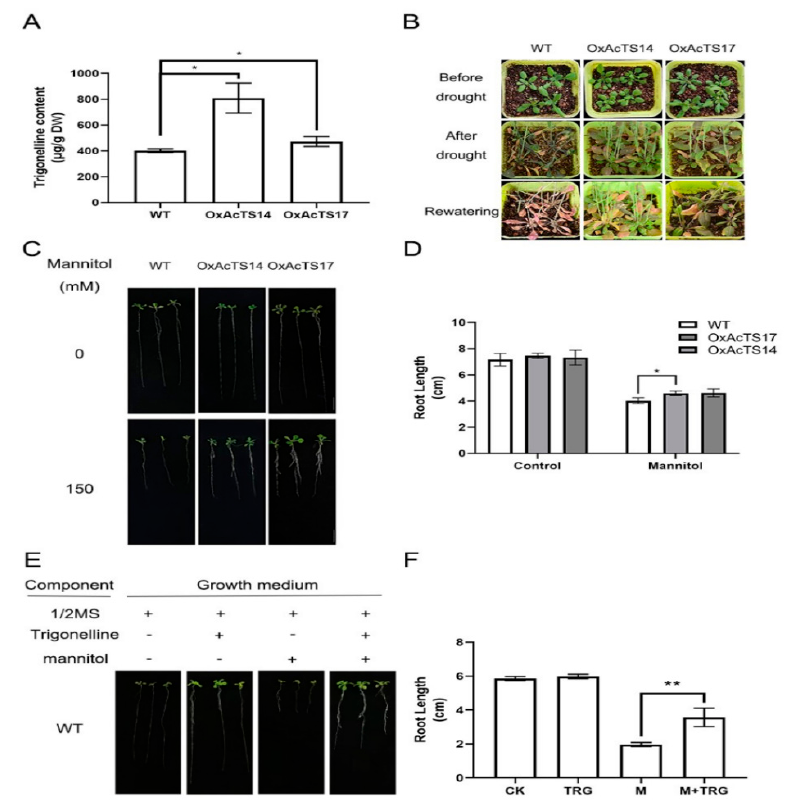
Figure 5. The potential role of AcTS in response to drought. ( A ) The content of trigonelline in Col-0 and transgenic Arabidopsis overexpressing AcTS (OxAcTS14 and OxAcTS14). ( B ) The phenotype of Col-0 and OxAcTS under drought and rehydration treatments. ( C ) The phenotype of Col-0 and OxAcTS on half-strength MS medium and half-strength MS medium supplemented with mannitol. ( D ) The root length of Col-0 and OxAcTS on half-strength MS medium and half-strength MS medium supplemented with mannitol. ( E ) The phenotype of Col-0 on half-strength MS medium, half-strength MS medium supplemented with trigonelline, half-strength MS medium supplemented with mannitol and half-strength MS medium supplemented with trigonelline and mannitol. A minus ( − ) sign indicates that the growth medium lacked the corresponding component, and a plus (+) sign indicates that the growth medium was supplemented with the corresponding ingredients. ( F ) The root length of Col-0 on half-strength MS medium, half-strength MS medium supplemented with trigonelline, half-strength MS medium supplemented with mannitol and half-strength MS medium supplemented with trigonelline and mannitol. Data are expressed as the means ± standard errors of the means. * p value < 0.05; ** p <